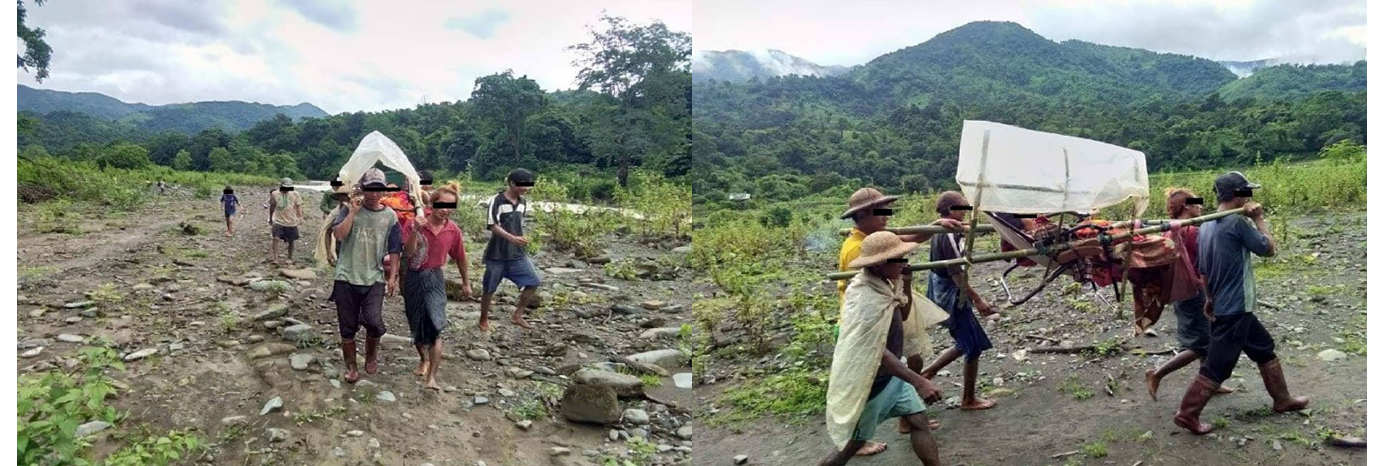
Figure 2. Common transportation method in rural area of Myanmar (photo taken near Matupi